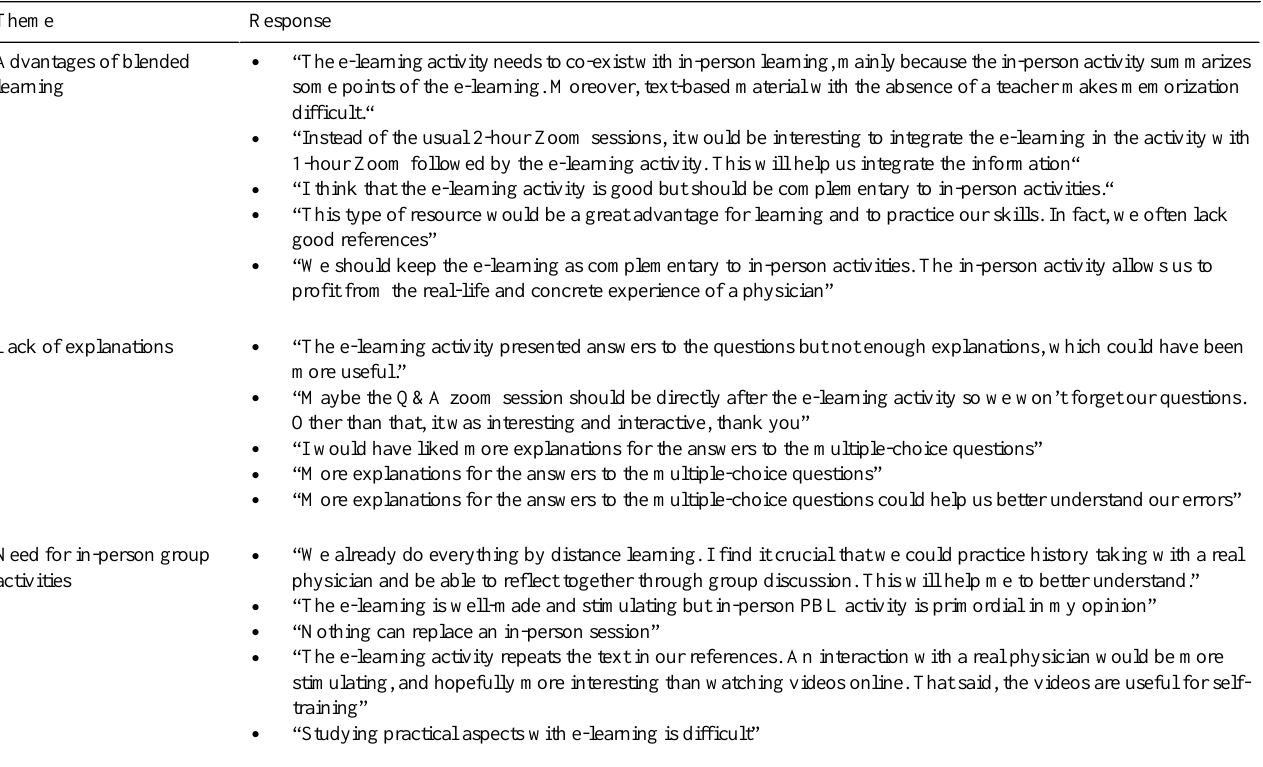
Table 3. Novice learners’qualitative inputs (translated from French).